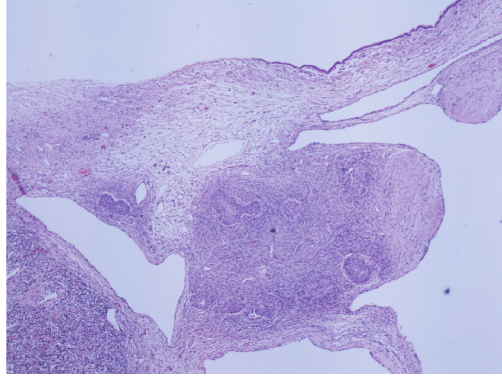
Figure 5: The three components: RCC, Brenner tumour, and Mucinous cystadenoma.